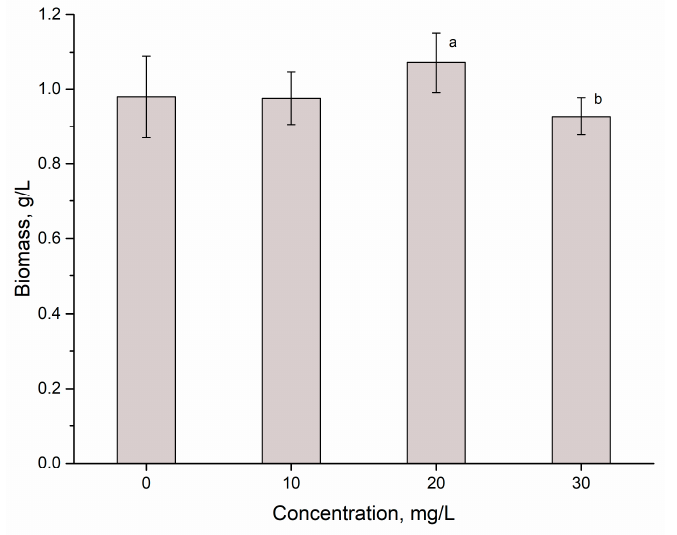
Figure 3. The influence of Y(III) applied in concentrations range of 10–30 mg/L on the amount of biomass of Arthrospira platensis (a— p < 0.005, b— p < 0.01 for the difference between experimental samples and control).